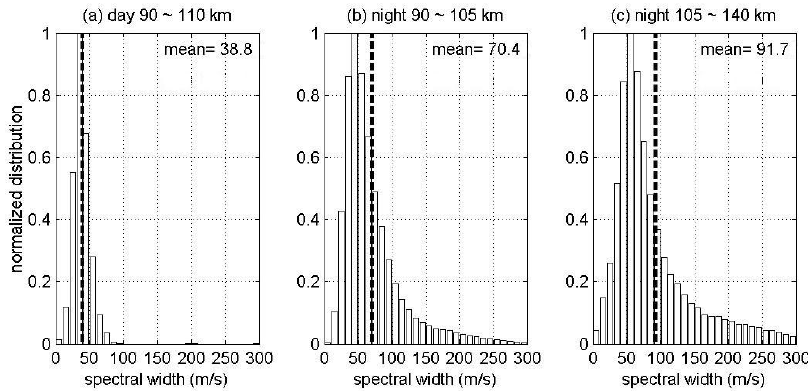
Fig. 5. The histograms of the spectral widths of the echoes for three categories: (left) daytime FAI echoes at 90–110km range, (central) Fig. 5 nighttime FAI echoes at 90 to 105km range, and (right) nighttime FAI echoes at 105 to 140km